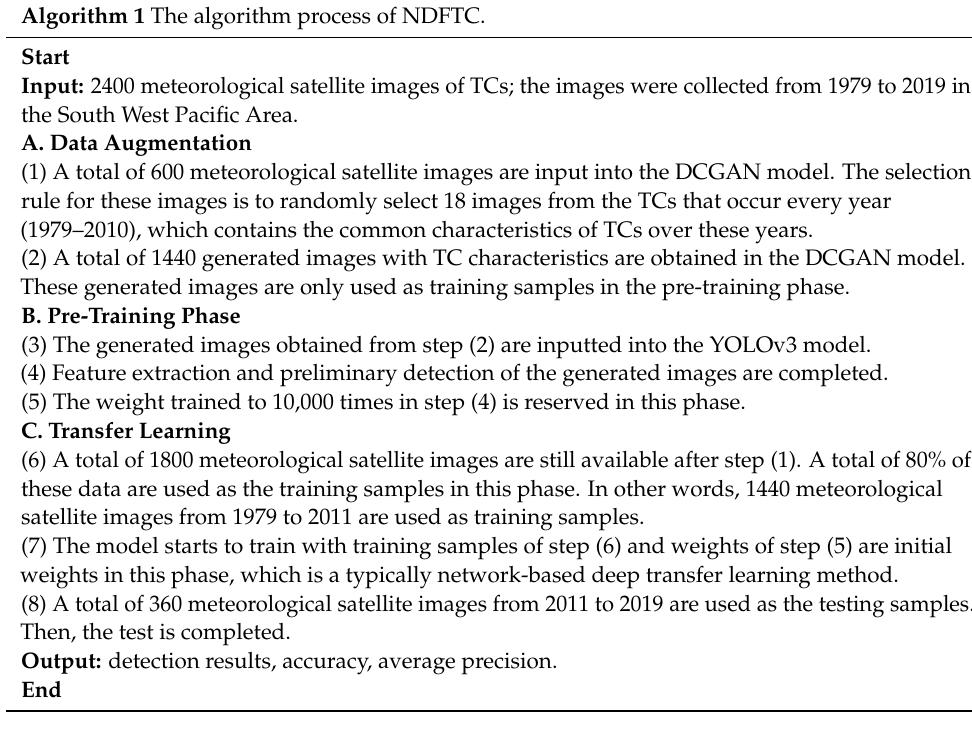
Algorithm 1 The algorithm process of